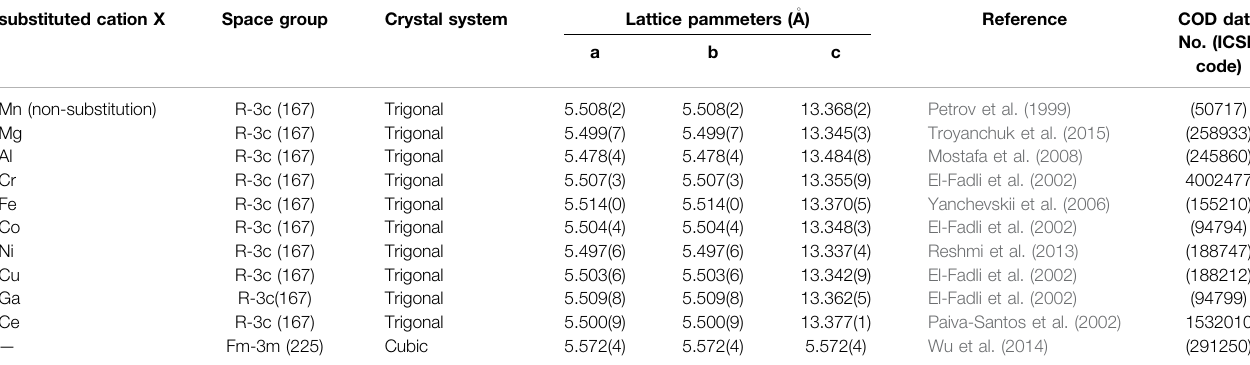
TABLE 2 | Substitution cation (X), space group, crystal system, and lattice parameters of re fi ned structured of X-substituted LSMs. substituted cation X Space group Crystal system Lattice pammeters ( (cid:1) A) Reference COD data